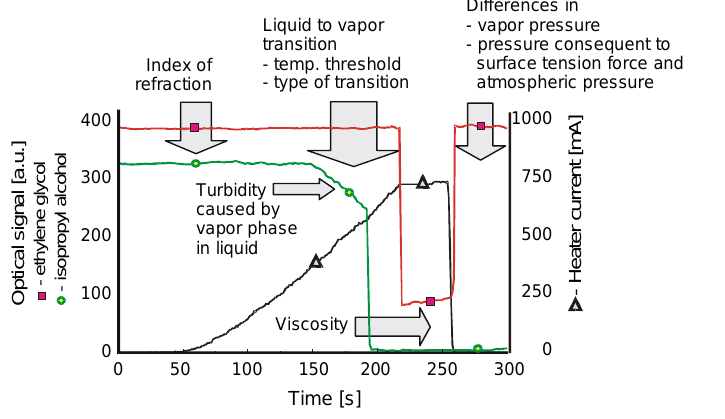
Figure 13. Signals registered from isopropyl alcohol and ethylene glycol liquid-to-vapor